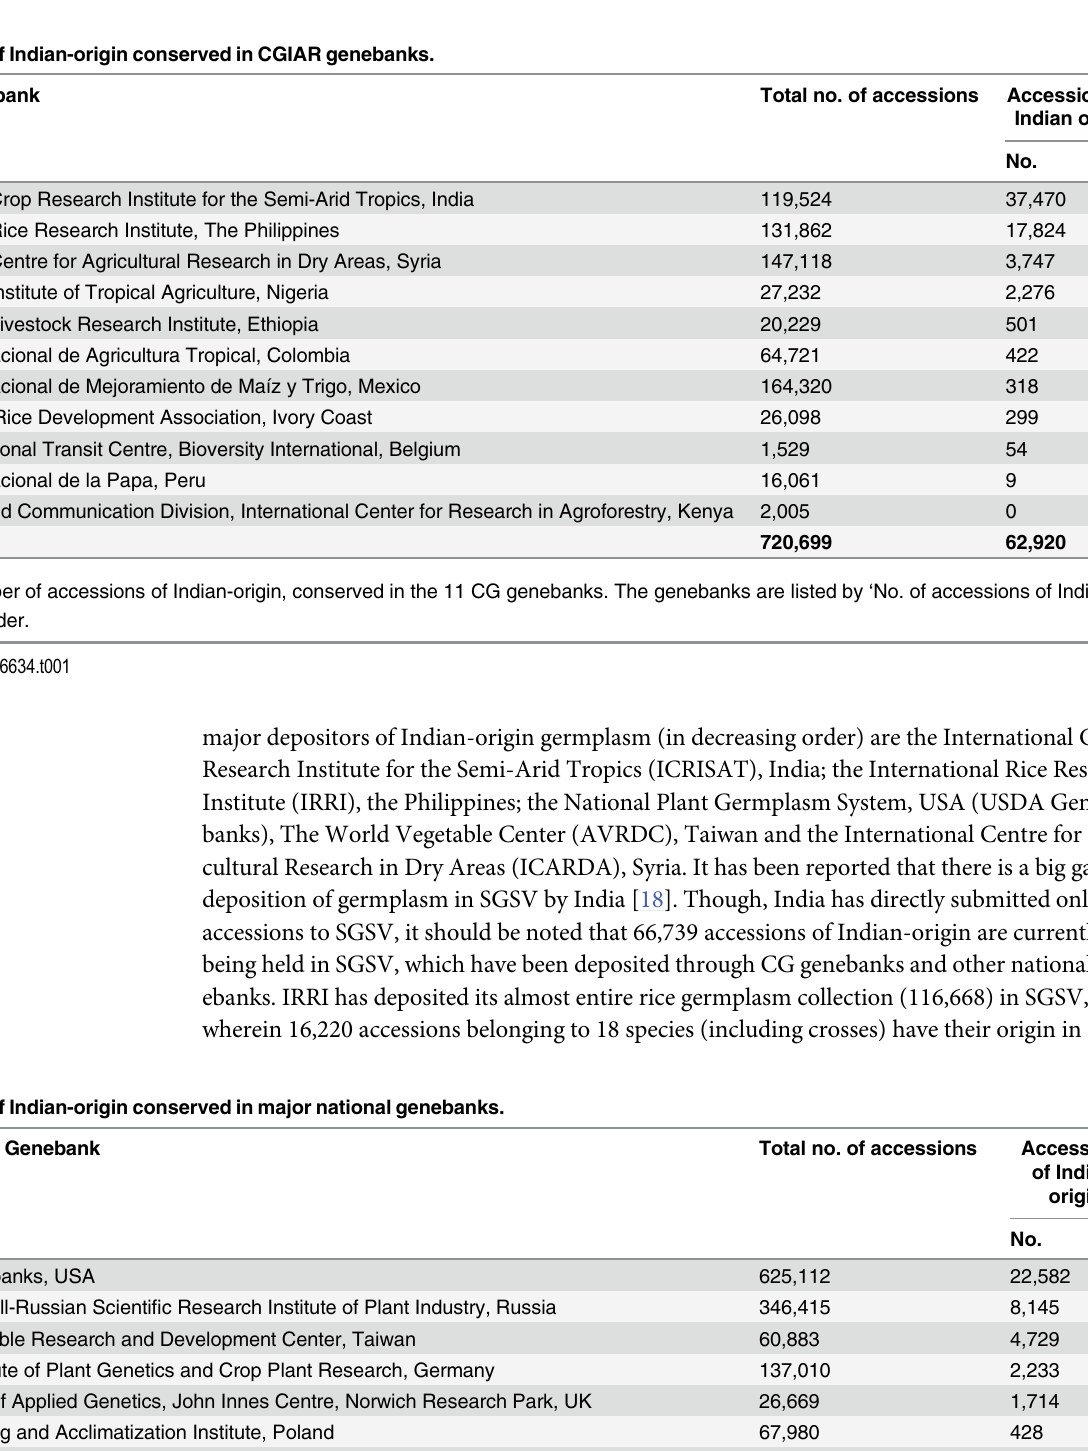
The table lists the number of accessions of Indian origin, conserved in the major national genebanks. The genebanks are listed by ‘ No. of accessions of Indian origin ’ in descending